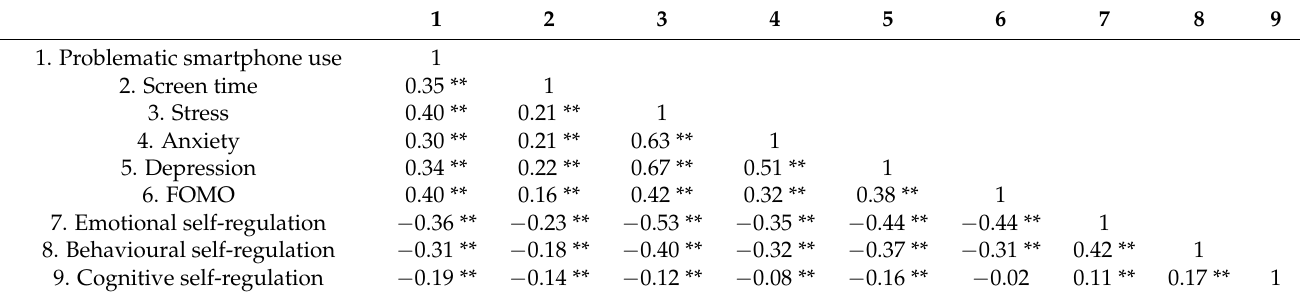
Table 2. Correlations among Main Study Variables.